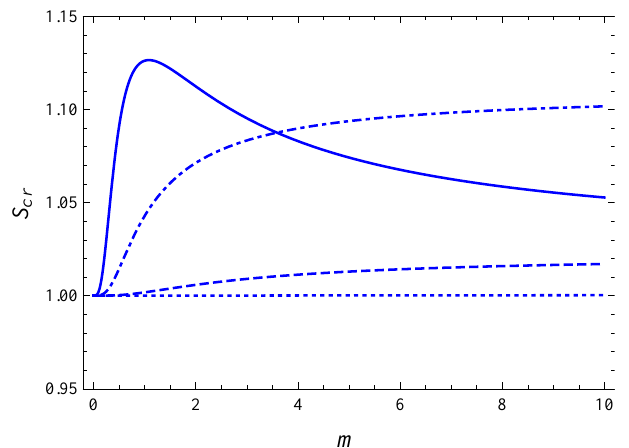
Figure 5. Particle creation entropy, S cr , as a function of mass m for fixed values a = 1, b = 2, c = 1, λ = 1.5 and the different values of momentum k = 0.5 (solid), k = 1 (dotdashed), k = 2 (dashed), and k = 4 (dotted)